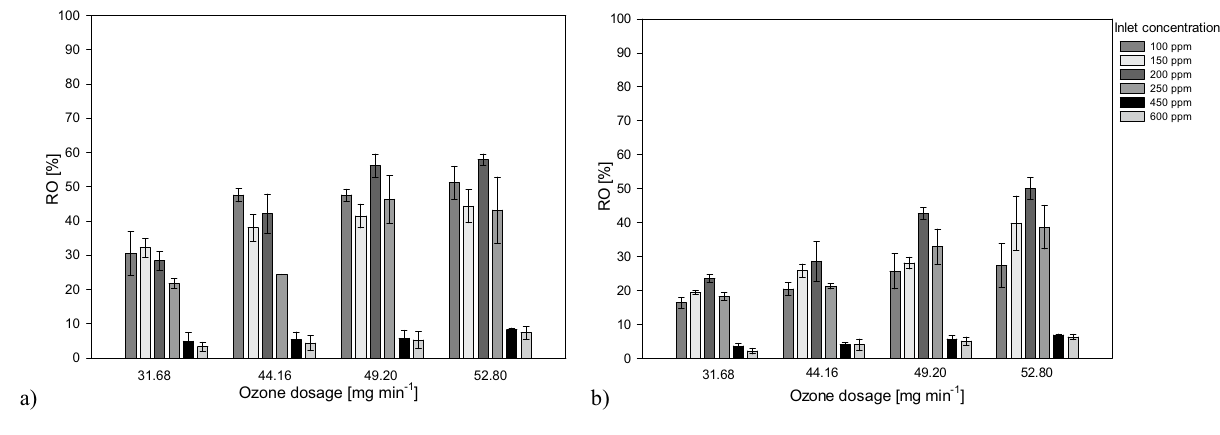
Figure 2. Influence of toluene inlet concentration on the Residue Ozone (RO) under different ozone dosage applying the UV/O 3 system ( a ) and the UV/O 3 + S system ( b ).